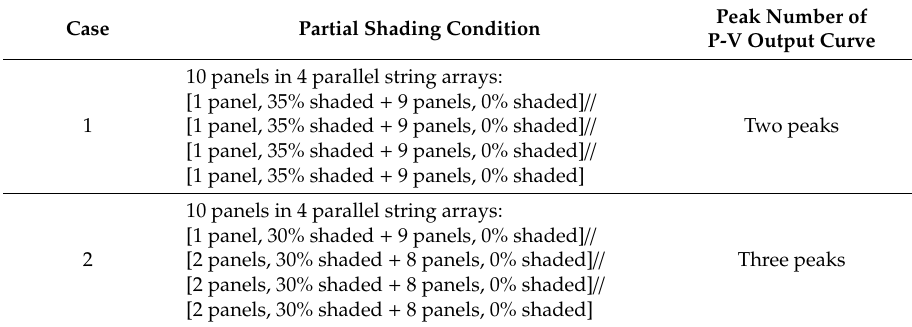
Table 5. Output characteristics of the proposed photovoltaic module array under the four partial shading conditions.